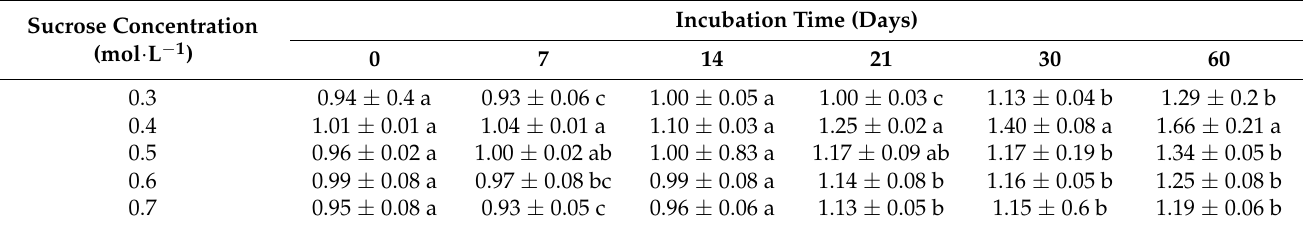
Table 3. Changes in the fresh weight of F. mandshurica embryogenic callus with culture time under different sucrose concentrations.